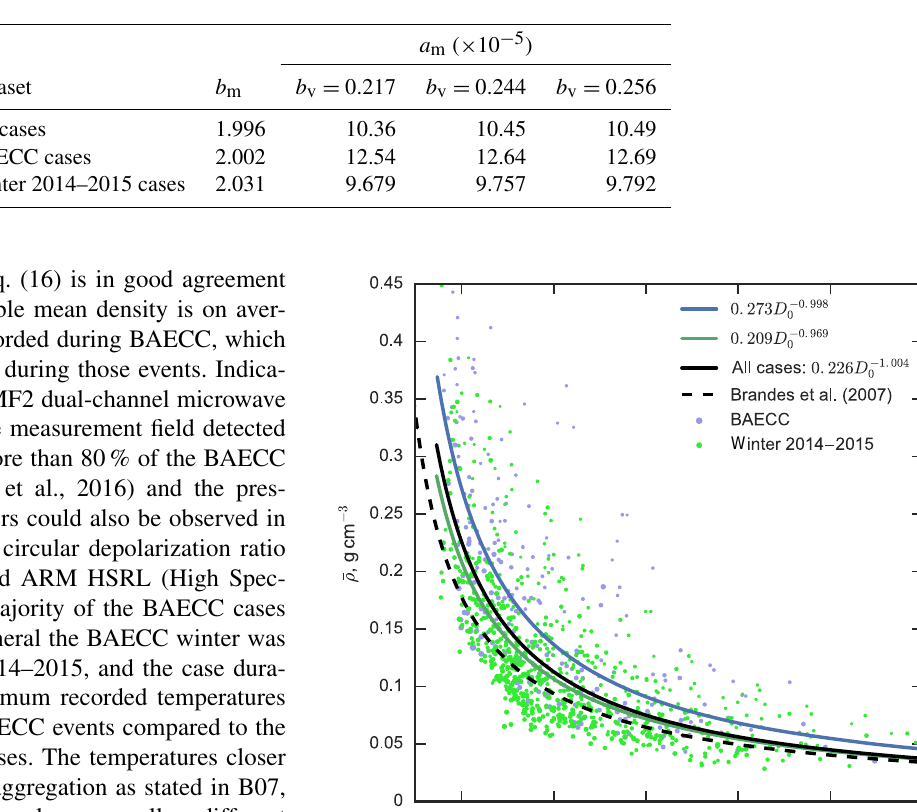
Table 2. The prefactors and exponents of m = a m D b m derived for exponential PSD with different values of exponent b v of velocity relation. The mass given in grams and the volume-equivalent diameter proxy in millimeters.